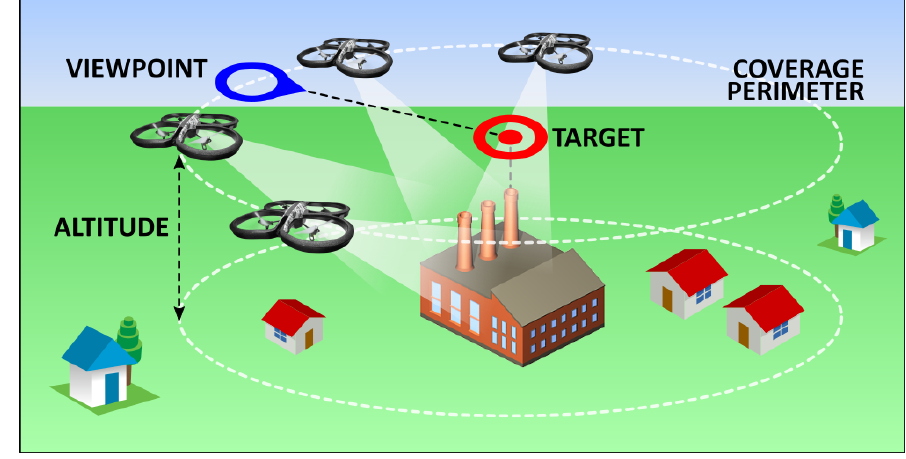
Figure 9. Fleet control illustration.